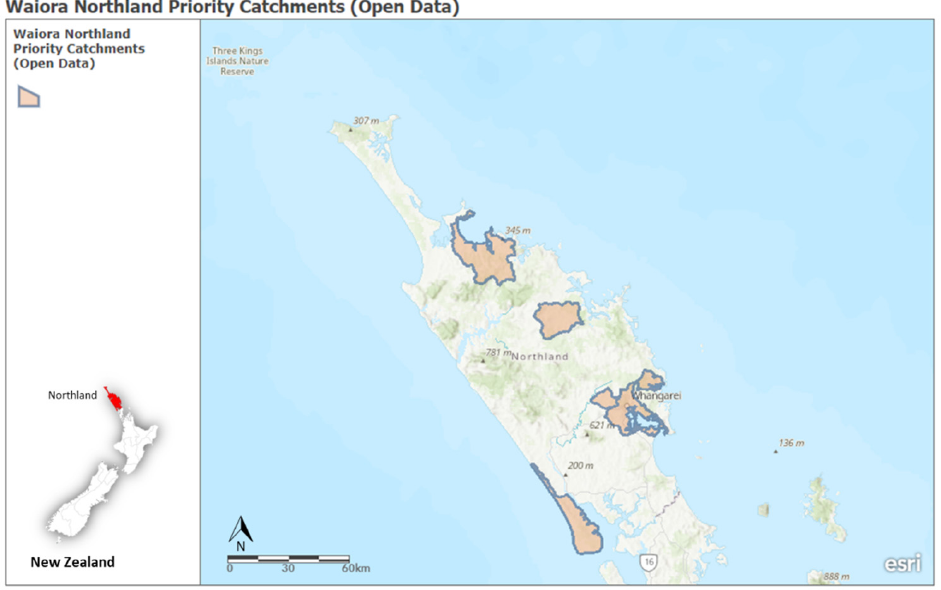
Figure 4. Map of the study area (Source: Authors, modified from Northland priority catchment open data maps).